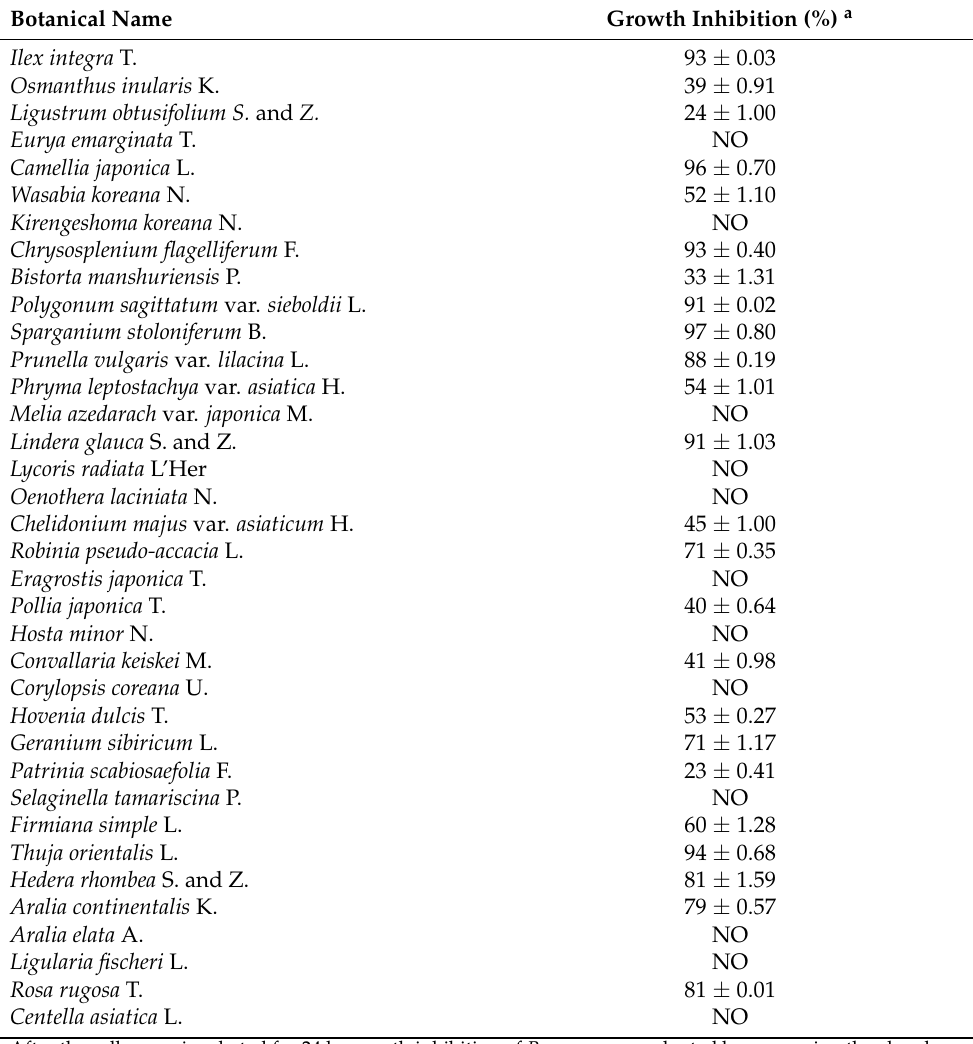
Table 3. Antimicrobial activities of plant extracts against P. acnes in broth dilution